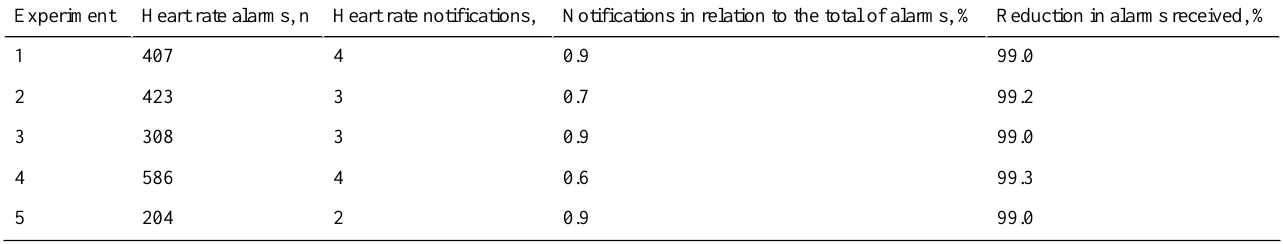
Table 3. Results of our experiments to evaluate our reasoning algorithm about how to notify caregivers considering the reduction of the number of notifications received by